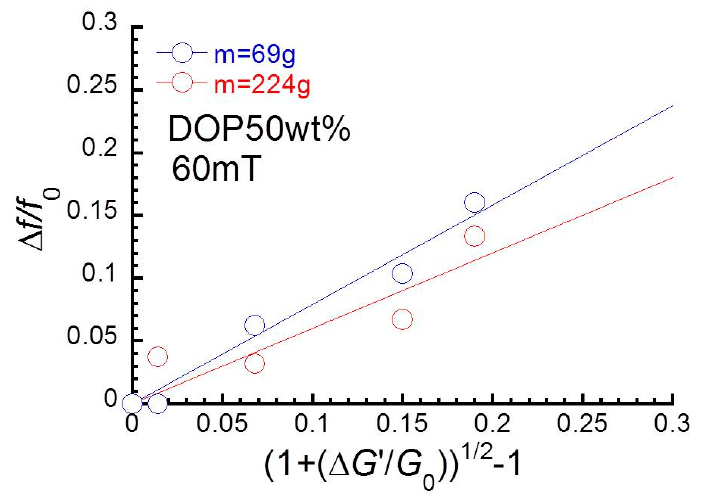
Figure 5. Relationship between the change in natural frequency and the value calculated from Equation (1) for all magnetic elastomers under two different loads.